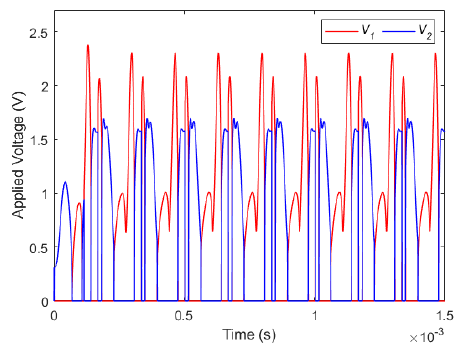
Figure 6. The relevant phase portrait for manifold s and s of Figure 2. Correspondingly, the variation of control parameters V 1 and V 2 are both depicted in the Figure 7. As can be seen from this figure, the control voltage does not exceed 2.5 volts, which is a reasonable applied DC load amplitude for MEMS capacitors.